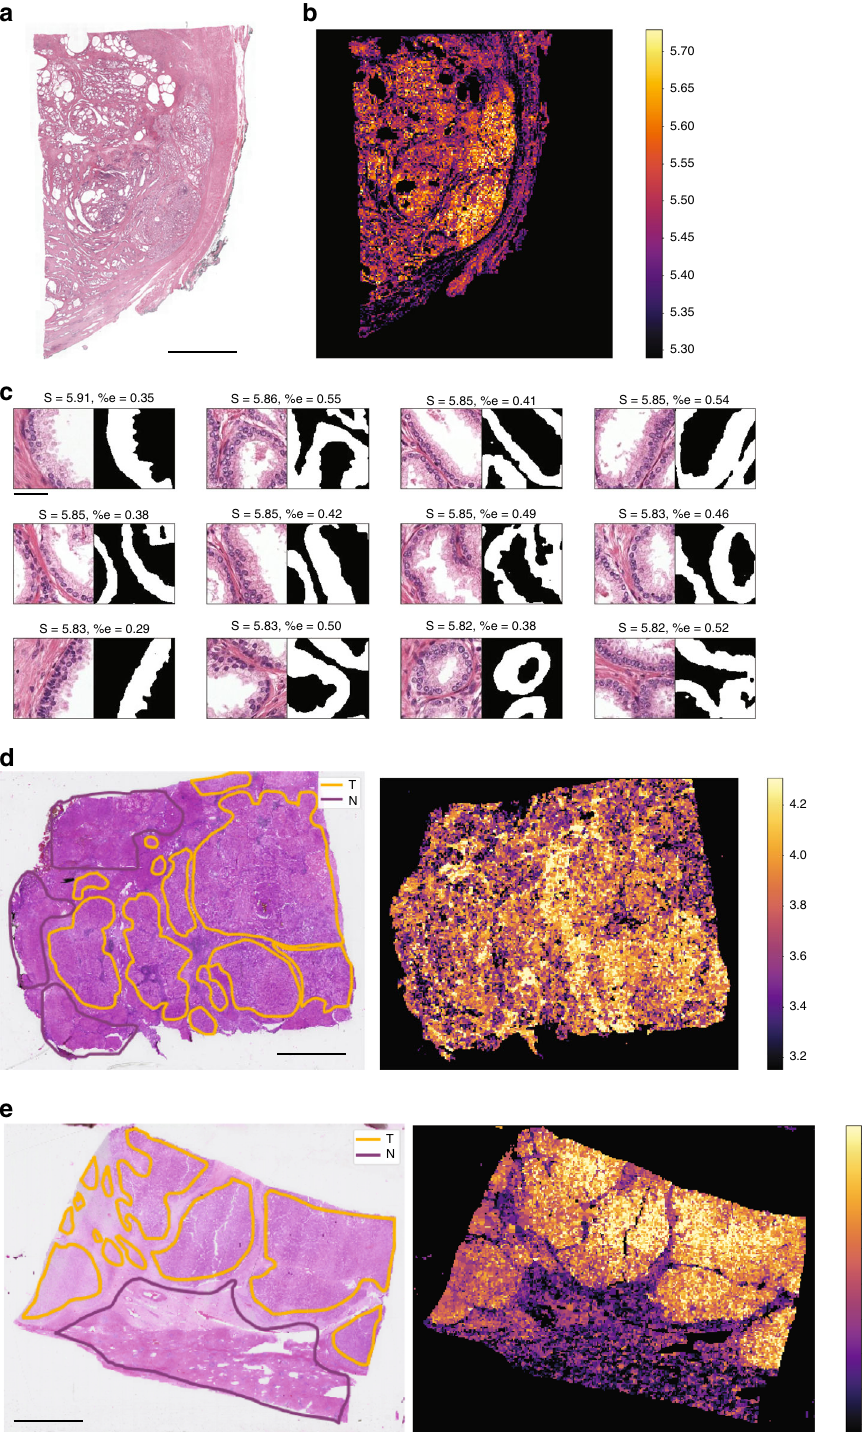
Fig. 5 Virtual spatialization of epithelium-associated genes ( TP63, KRT8 , and KRT18 ) and MKI67 expression. a Representative H&E slide from the PESO dataset 59 ( n = 62 slides with segmentation mask). b . Heatmap for the expression of TP63 , KRT8 , and KRT18 predicted by HE2RNA for the slide in a . c Tiles with highest predicted expression for those genes on this slide, with the segmentation mask of epithelium obtained from an IHC staining of the same slide 42 . S = Score corresponding to the log expression score of each tile; %e = fraction of pixels marked as belonging to the epithelium ( n = 21,714 tiles in total). d Spatialization of MKI67 predicted expression on a liver hepatocarcinoma sample from an early stage tumor (BCLC stage A) ( n = 284 samples) 43 . Left panel: Representative H&E staining, with annotation of tumor (T) and nontumor (N) areas performed by a pathologist. Right panel: Heatmap for the expression of MKI67 predicted by the model. e Same as d , for a sample from an advanced tumor (BCLC stage C) ( n = 65 samples). In a , d , e , scale bar: 5 mm. In c , scale bar: 100 µ m. d , e are representative slides ( n = 369 annotated slides). BCLC Barcelona Clinic Liver